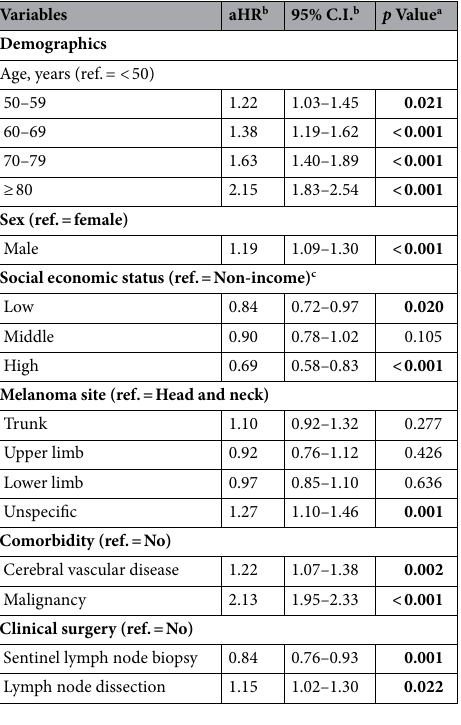
Table 2. Demographic and clinical characteristics of patients in the mortality by Cox-proportional hazard regression analysis with stepwise model ( n = 3284). a Using Cox proportional hazard model. Bold type indicates statistical significantly ( P < 0.05). b Abbreviations: aHR adjusted hazard ratio, C.I. confidence interval. c